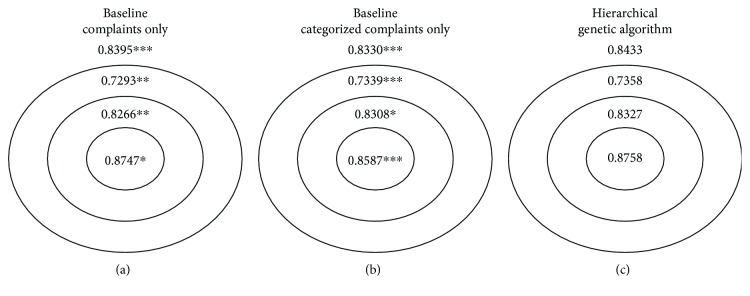
Bullseye performance for baseline models (with specific complaints only and complaint categories only, resp.) and hierarchical genetic algorithm for the academic hospital. Overall performance is indicated outside of the bullseye. Statistical significance for the difference in 5-fold cross-validated AUC (using DeLong's method) between the flattened genetic algorithm approach and the corresponding baseline models is indicated by ∗∗∗ for p < 0.001, ∗∗ for p < 0.01, and ∗ for p < 0.05.